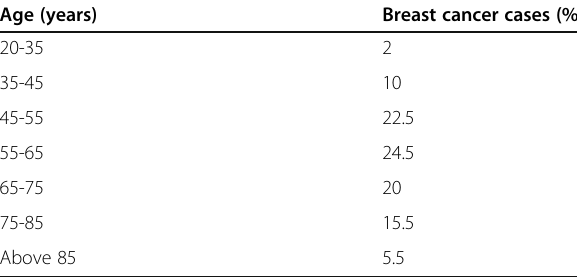
Table 1 Incidences of breast cancer with increasing age [3]